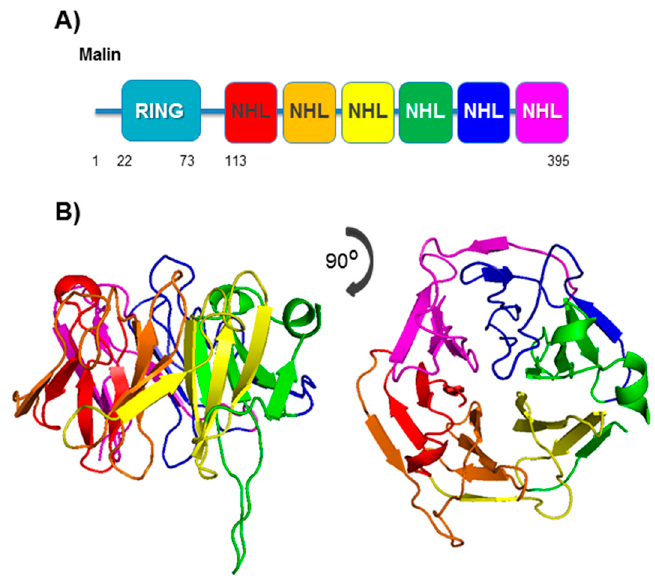
Figure 2. Structural view of malin. ( A ) Diagram of the different structural domains in malin; the position of the RING (Really Interesting New Gene) and NHL (NCL1, HT2A and LIN-41 containing) domains is indicated. ( B ) In silico modeling of NHL domains. The protein sequence of malin containing the NHL domains was submitted to the ESypred3D server and modeled using the structure of M. tuberculosis PknD (PDB:1rwl) as template. Each NHL domain is stained with a different color and side and top views are on the left and right panels, respectively.